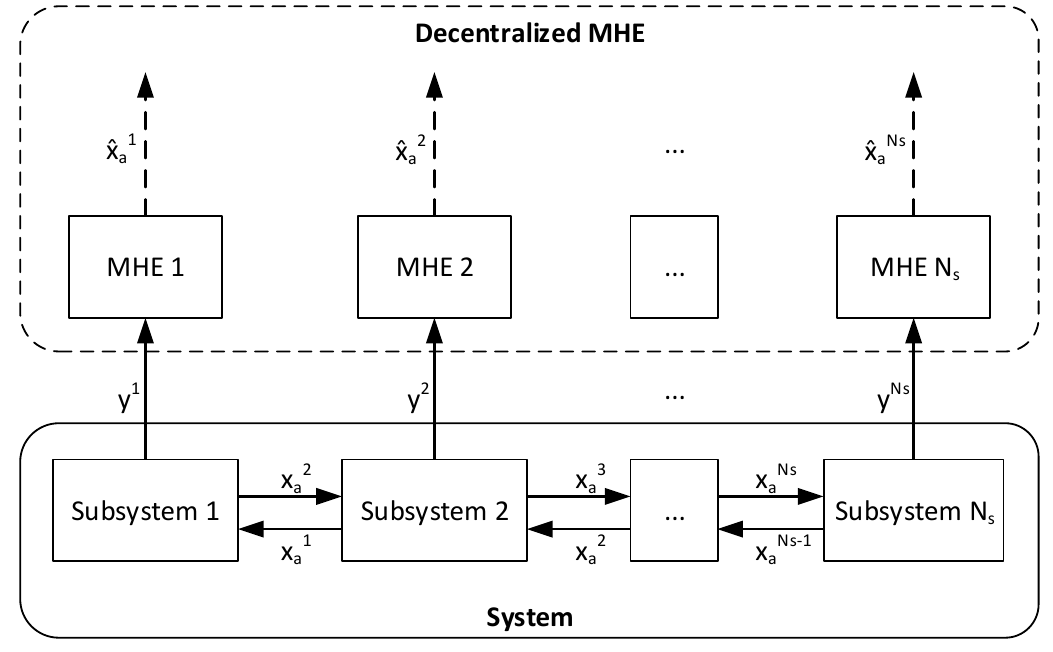
Figure 3. A schematic diagram of the proposed decentralized estimation scheme.